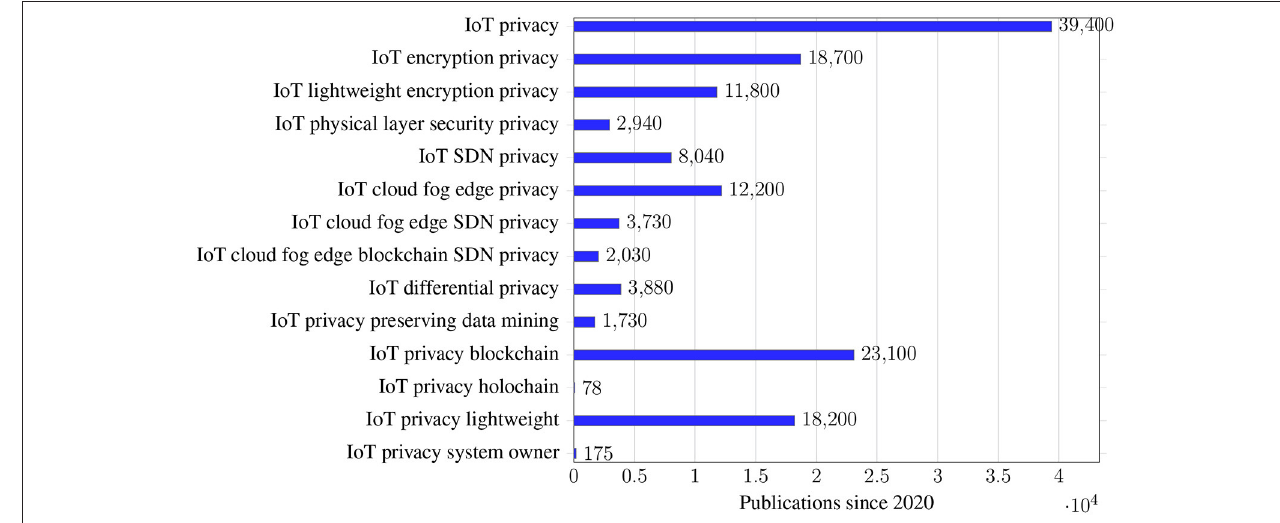
FIGURE 3 | Total publications by research topics from 2020 to 2021 (from Google Scholar